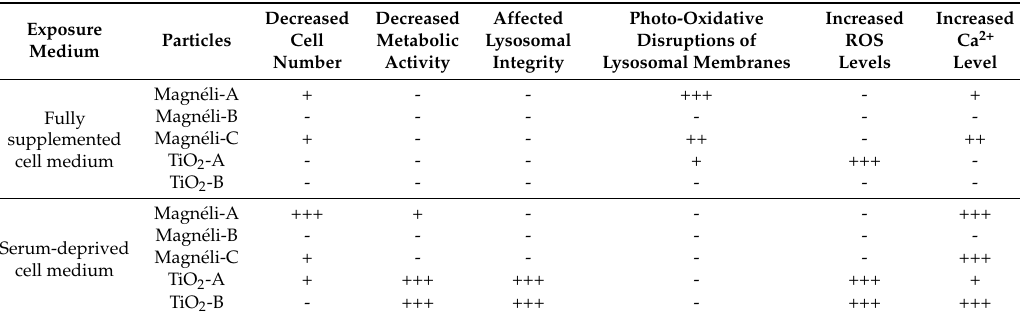
Table 2. A summary of results obtained in the